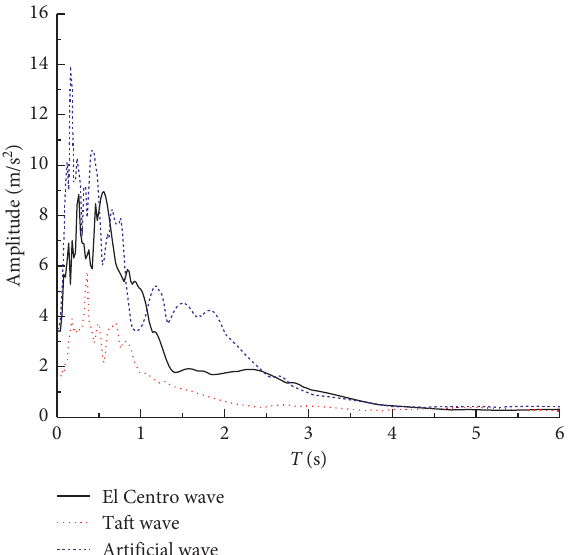
Figure 5: Acceleration response spectrum of three waves.